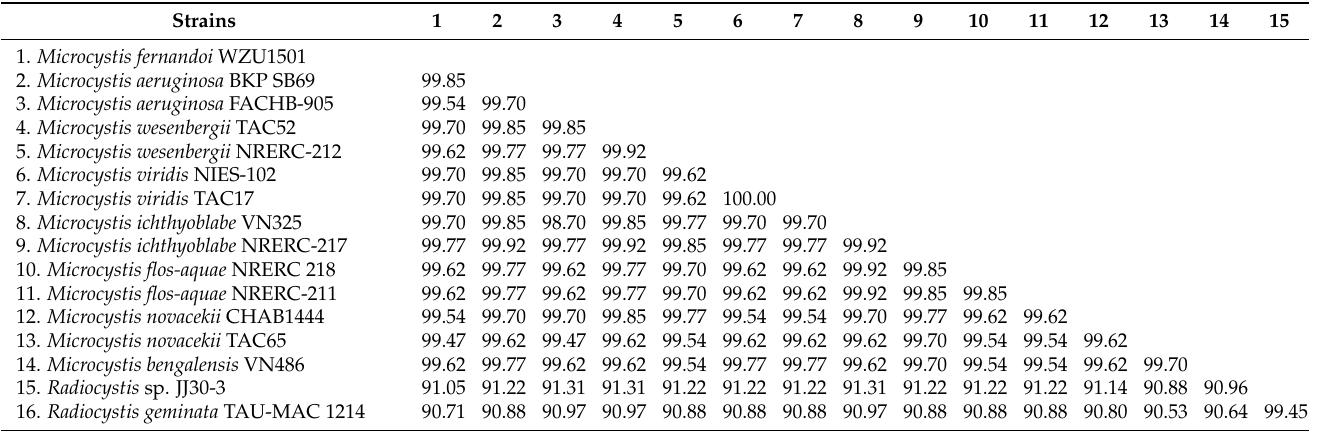
Table 1. Sequence similarity comparison of the 16S rRNA gene between Microcystis fernandoi WZU 1501 and other related taxa. Similarity = [1 − (p-distance)] ×